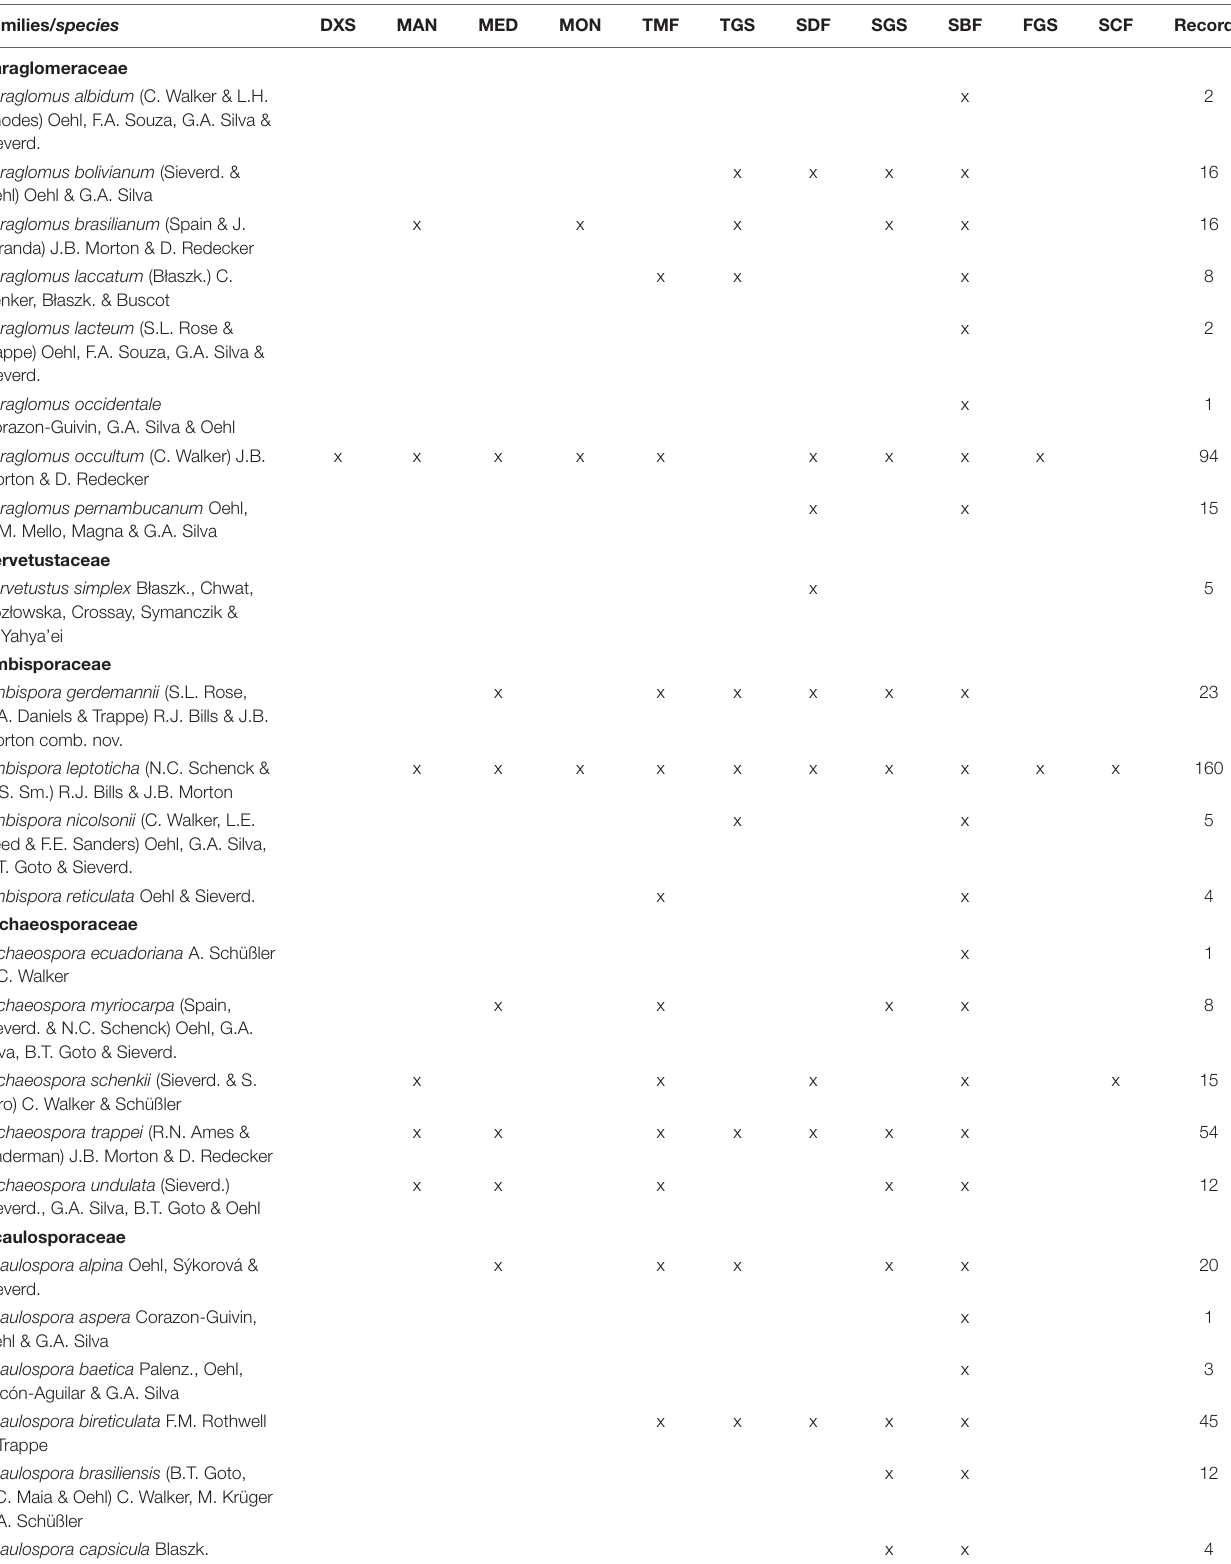
TABLE 1 | Families and species of Glomeromycota occurring in Neotropics biomes. Families/ species DXS MAN MED MON TMF TGS SDF SGS SBF FGS SCF